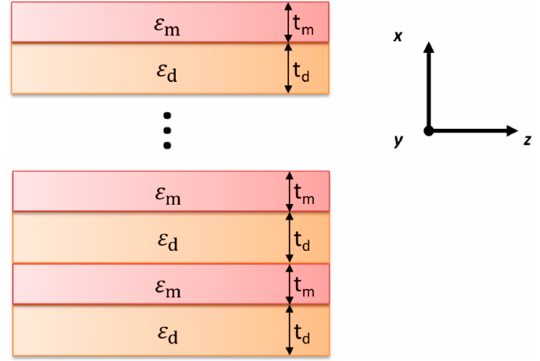
Figure 1. Schematic illustration of hyperbolic metamaterial.